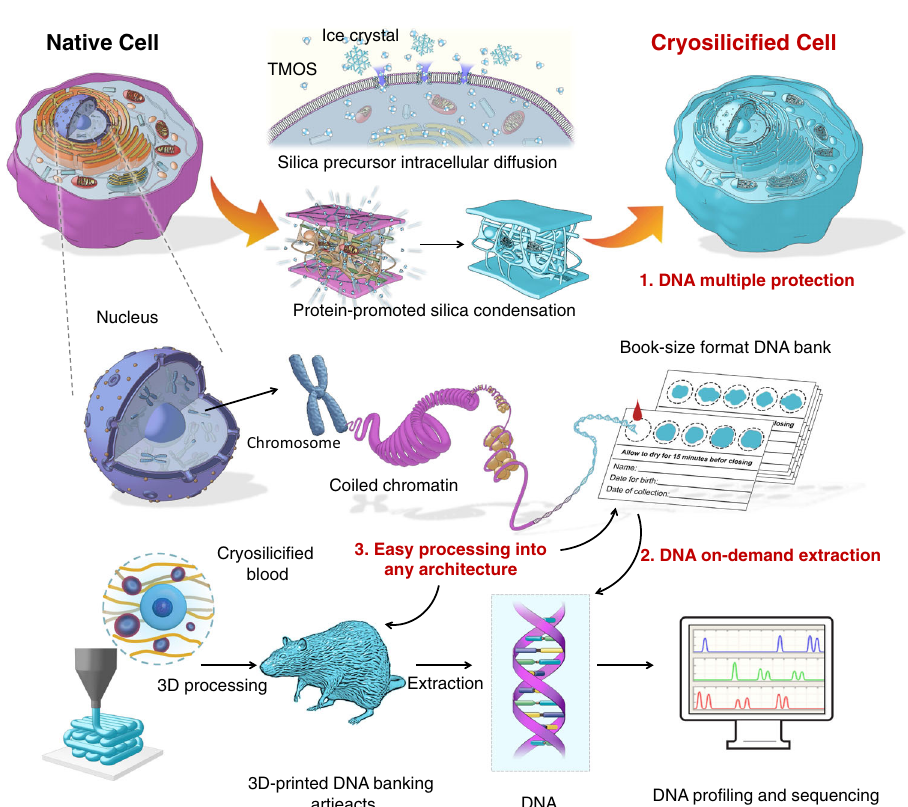
Fig. 1 | Schematic representation of the cell cryosilici fi cation process and the construction ofwhole bloodDNAbanking. The silicaprecursor diffuses into the cellandnucleusunderdormancy,andsubsequently,condensesunderthecatalysis of cellular protein. This self-limited silica condensation on sub-cellular templates preserves the entire cellular architectures, mimicking the hermetic sealing of DNA